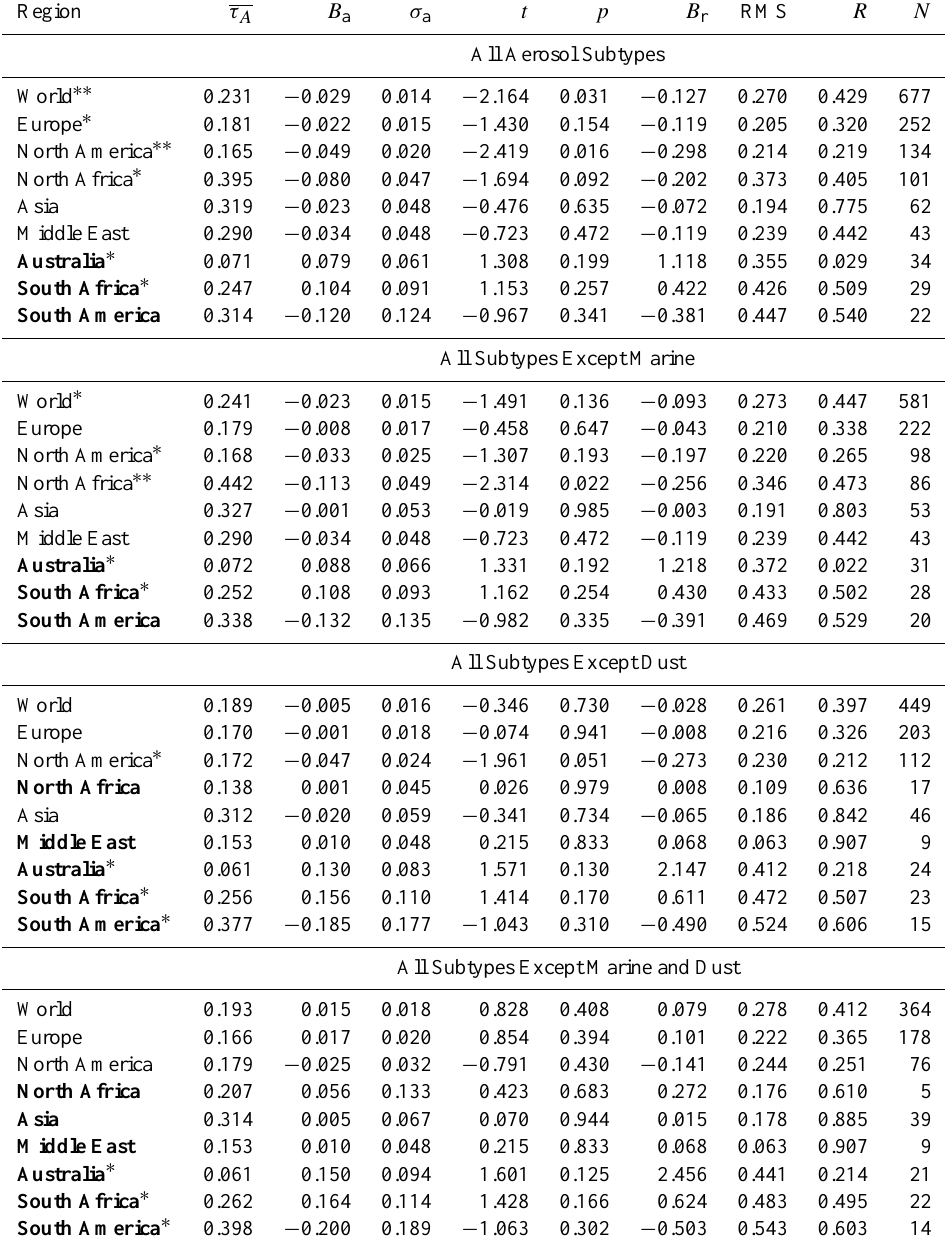
Table 3. Regional statistics for CALIPSO and AERONET comparisons with a maximum closest approach of 80km, including cases with- out marine or dust aerosols. Average AERONET aerosol optical depth at 0.532µm ( τ A ), absolute bias and absolute standard error ( B a , σ a ), student’s t-test score and p -value ( t , p ), relative bias, ( B r ), root-mean-square error (RMS), correlation coefficient ( R ), and number of compar- isons ( N ) are shown. Regions denoted with ( ∗∗ ) indicate absolute biases that exceed the 95% confidence interval of the means (i.e., t -score magnitudes greater than 2 and p -values less than 0.05). Regions denoted with ( ∗ ) indicate absolute biases that exceed the 67% confidence interval of the means. Regions with less than 43 overpasses are shown in